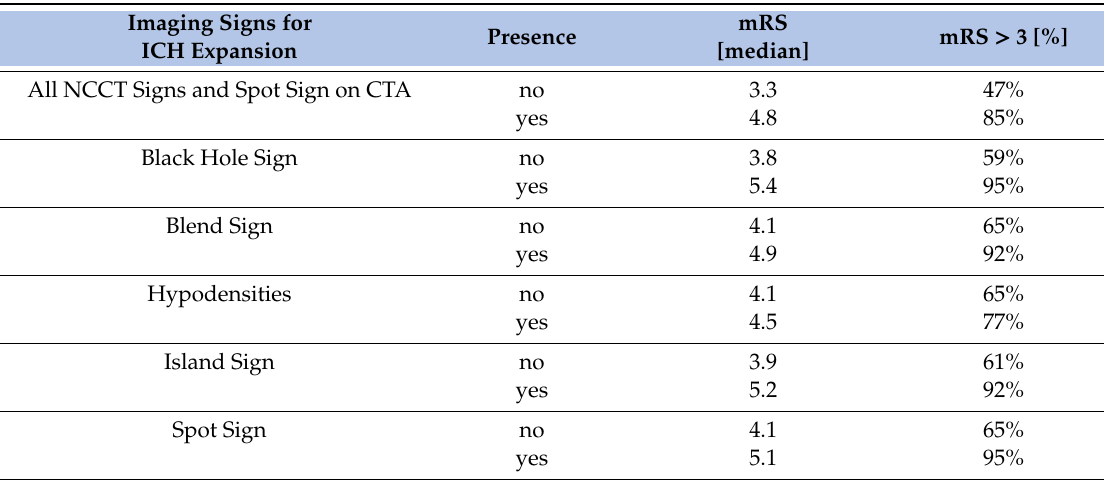
Table 3. Distribution of simultaneous appearance of imaging markers for early hematoma expansion in patients with spontaneous intracerebral hemorrhage.